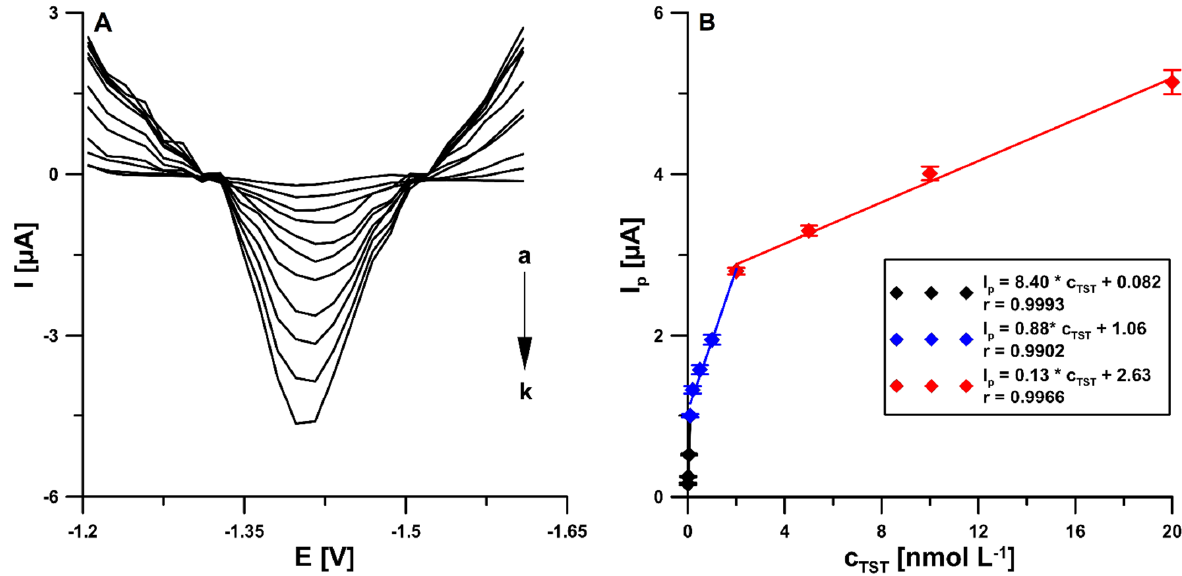
Figure 8. The DPAdSVs of the pSPCE/PbNPs in the presence of various TST concentrations (a → k, 1.0 × 10 − 11 –2.0 × 10 − 8 mol L − 1 ) in 0.075 mol L − 1 acetate buffer of pH 4.6 ± 0.1 and 7.5 × 10 − 5 mol L − 1 Pb(NO 3 ) 2 (A) .Calibraion graph of TST (B) . The obtained average values of the peak current are shown with standard deviation for n = 3. The DPAdSV parameters: t m of 5 ms, Δ E A of 150 mV, ν of 175 mV s − 1 , E Pb dep. and TST acc. of − 1.1 V and E Pb dep. and TST acc. of 120 s.